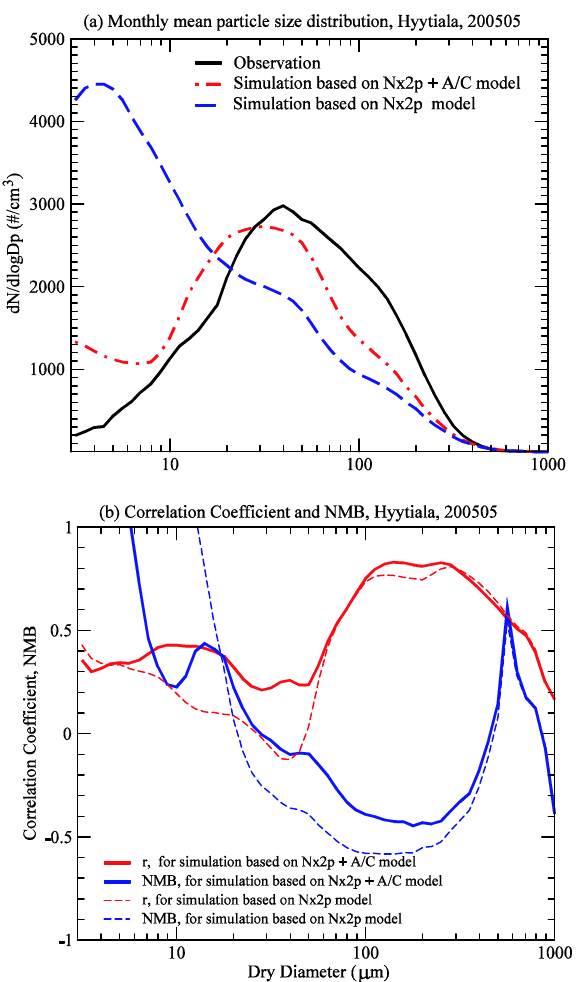
Figure 5. Fig. 5. (a) Same as Fig. 4 except for the monthly mean particle size distributions, (b) size-dependent correlation coefficient ( r ) between simulated and observed number concentrations of particles of dif- ferent sizes and the corresponding normalized mean bias (NMB).